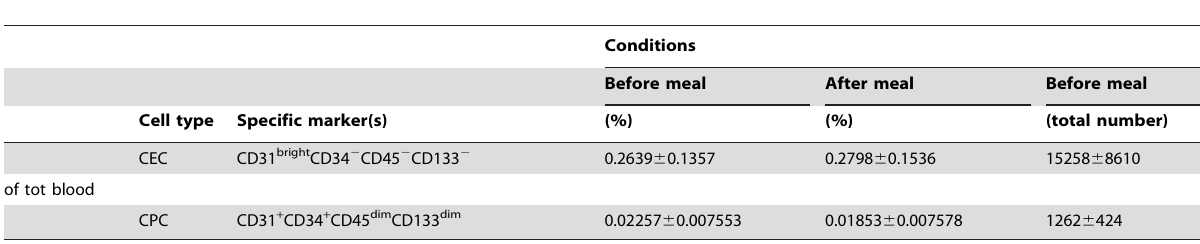
Data is displayed as mean 6 standard deviation.